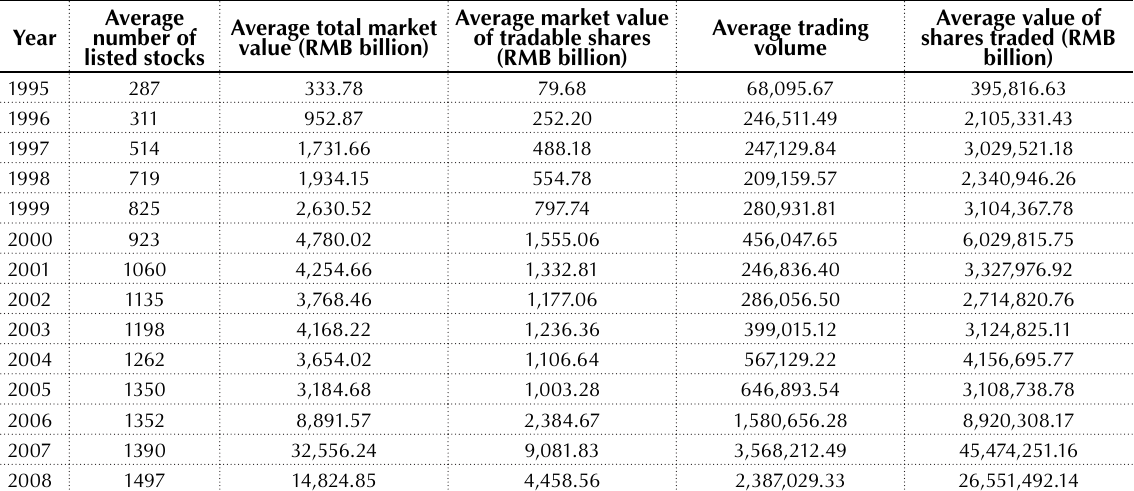
Table 1. Descriptive statistics for the Chinese A-share market over the period January 1995